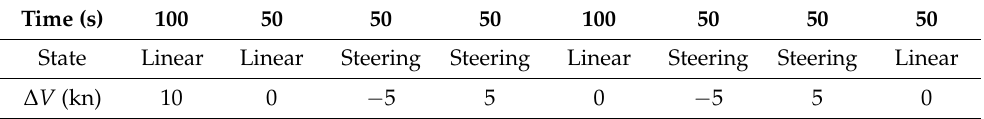
Table 5. Maneuver state.